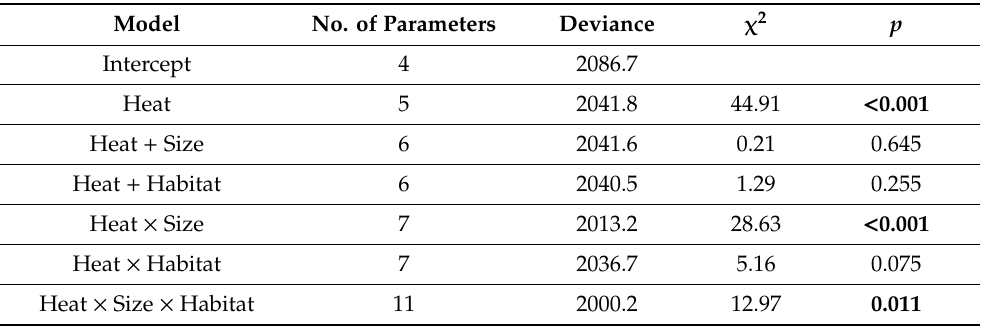
Table 1. Results of likelihood ratio tests (LRTs) showing the e ff ects of heat shock, seed size, habitat type and their interactions on seed germination of Cistus salviifolius . All models included population as random factor. Significant p -values ( < 0.05) are highlighted in